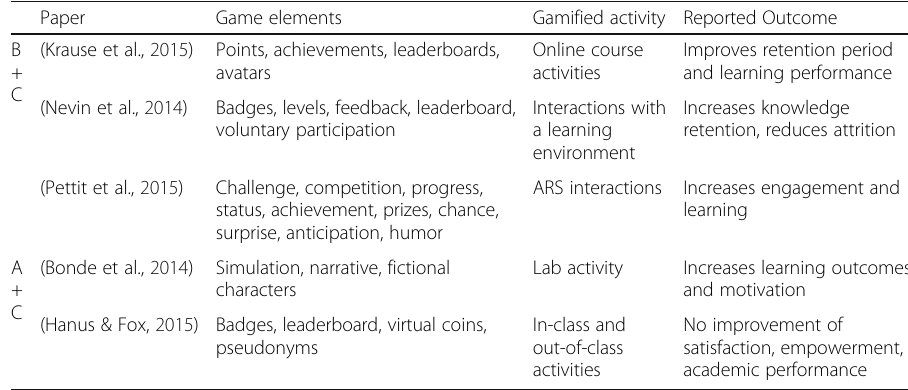
Table 11 Categorization of studies falling in two categories: Behavioral and Cognitive (B + C), Affective and Cognitive (A + C), Affective and Behavioral (A + B)